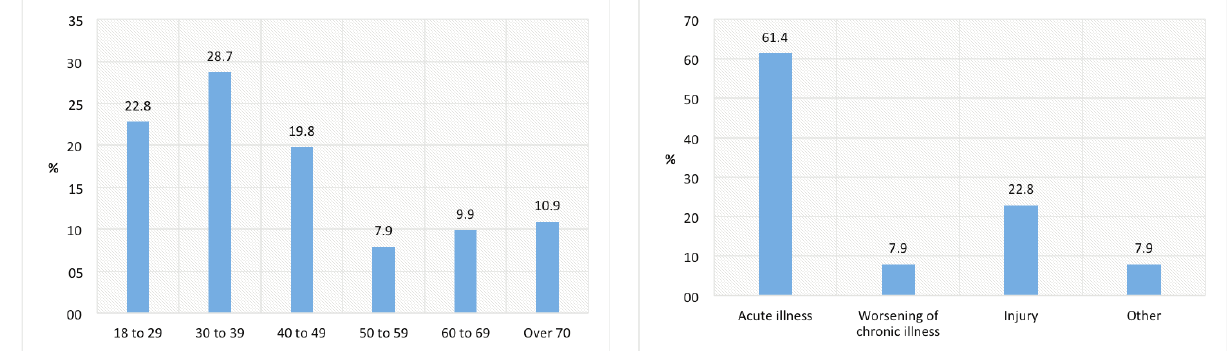
Figure 1: Age structure of sample – patients Figure 2: Reason for visiting the EMS